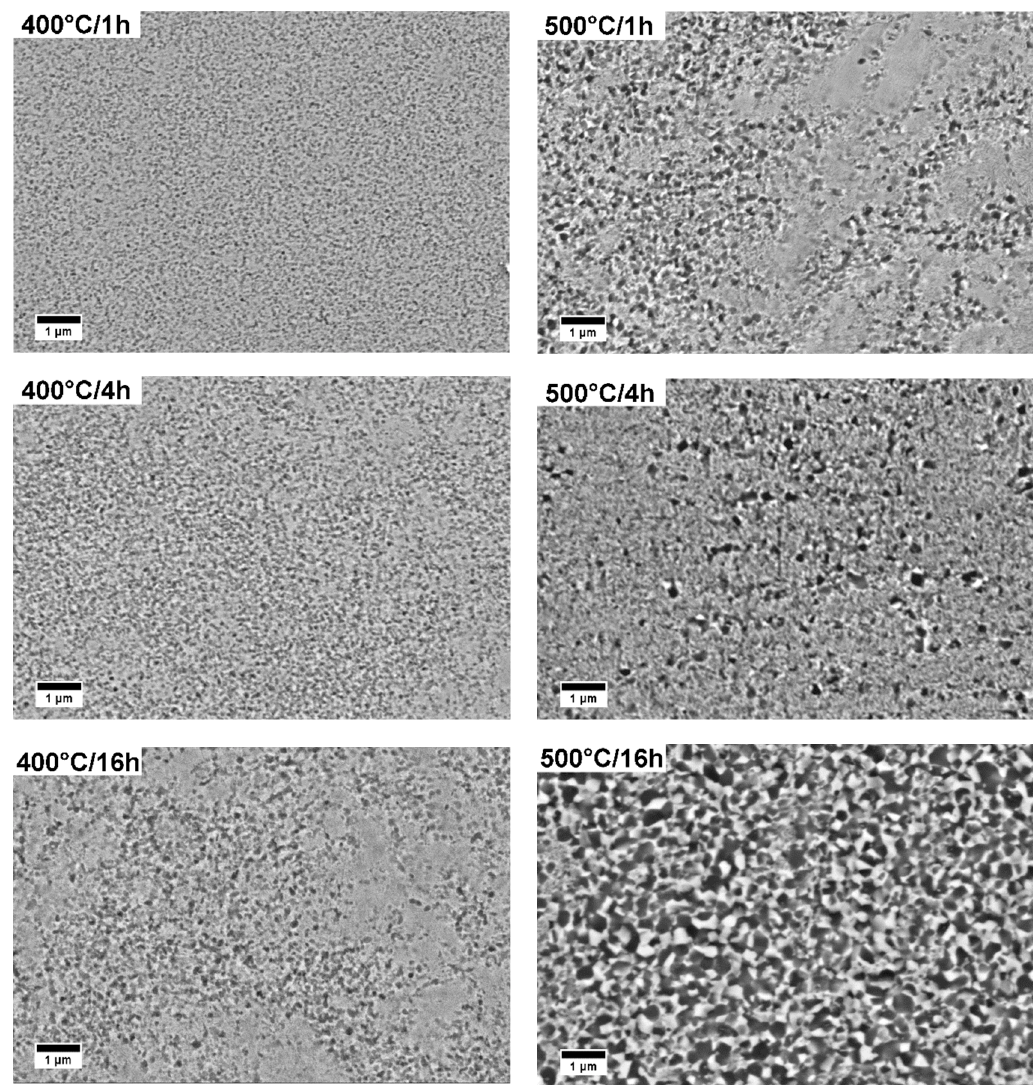
Figure 4. SEM–BSE images of the HPT samples after ageing at 400 ◦ C and 500 ◦ C for 1–16 h (ageing condition is indicated in the top left corner of each micrograph).